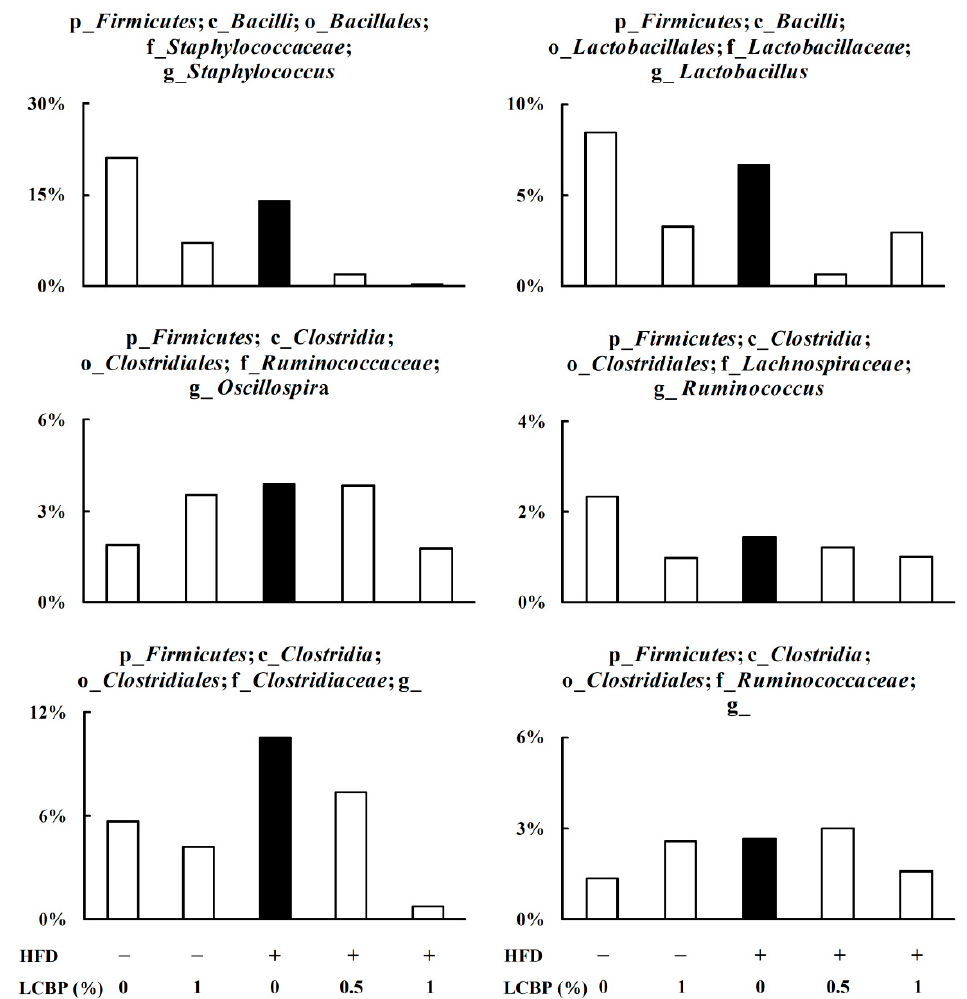
Figure 5. The effect of LCBP on the relative abundance of bacterial genera belonging to Firmicutes . Fecal microbiota were characterized by 16S rRNA gene sequencing, and the data represents the relative abundance of each bacterial genus. p_, c_, o_, f_or g_ represents phylum, class, order, family, and genus, respectively, and a blank after the letter means undefined. HFD, High fat diet; LCBP, Lonicera caerulea L. berry polyphenols.